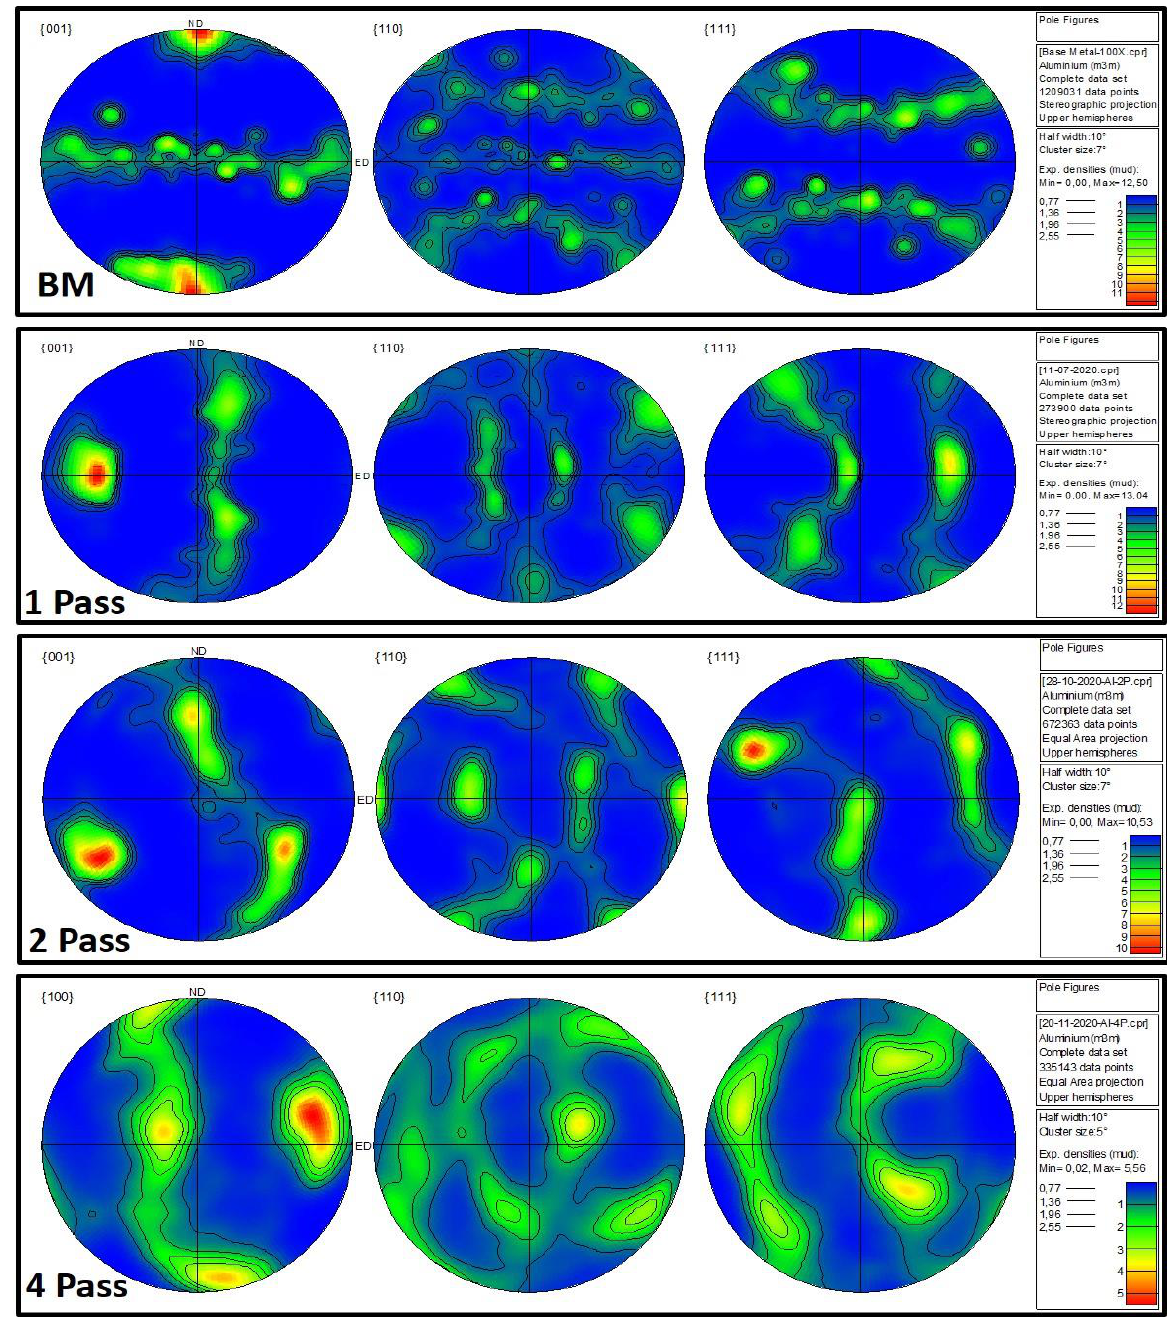
Figure 13. 100, 101 and 111 pole figures calculated from the EBSD data presented in Figure 10 for the AA2011 BM and after ECAP processing for different passes.